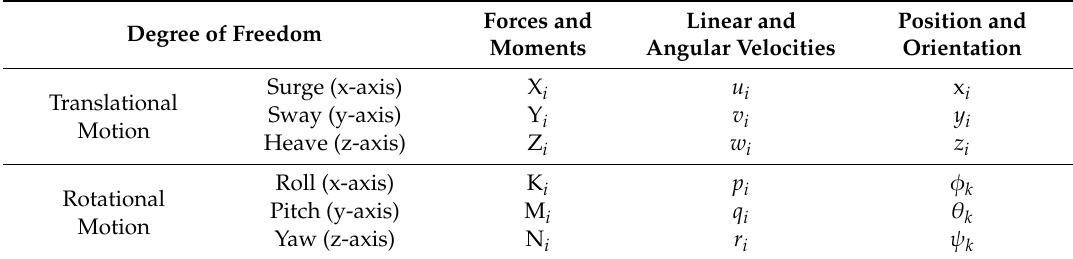
Table 1. Notation used for the USV and